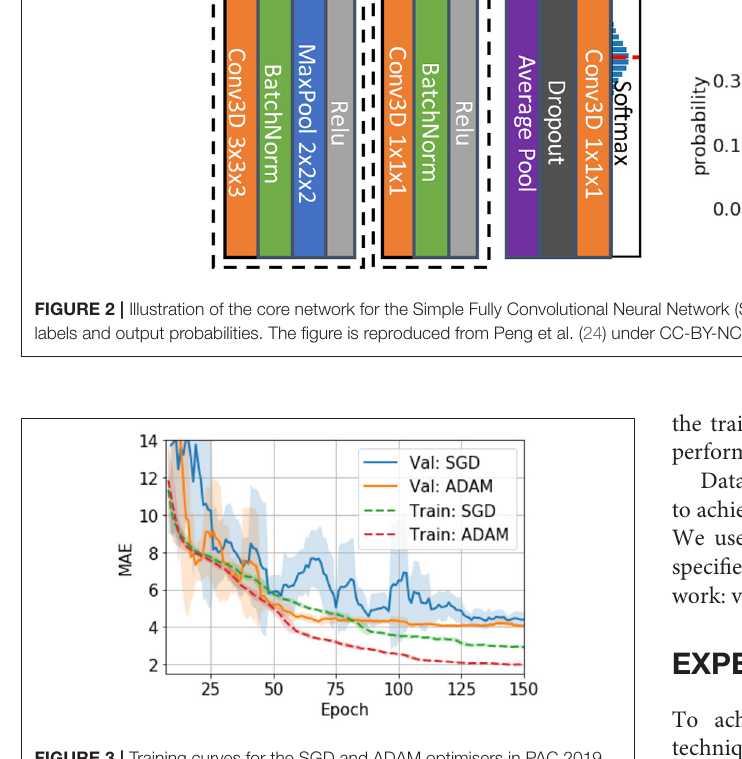
FIGURE 3 | Training curves for the SGD and ADAM optimisers in PAC 2019 data. The curves are smoothed with a 7-step averaging window. The shading areas show the standard deviation within the